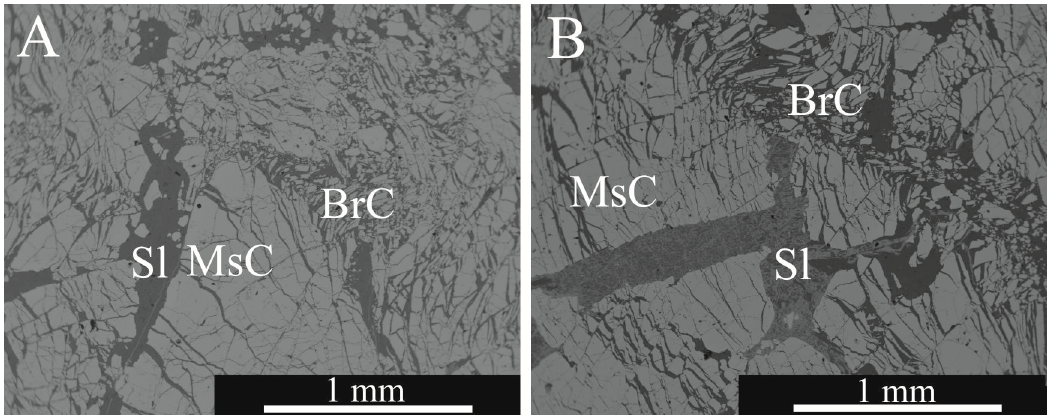
Figure 2. Back-scattered electron images (BSE) of massive and brecciated Othrys chromitite from polished sections ( A , B ). Abbreviations: Sl = silicates, MsC = massive chromite, BrC = brecciated chromite.